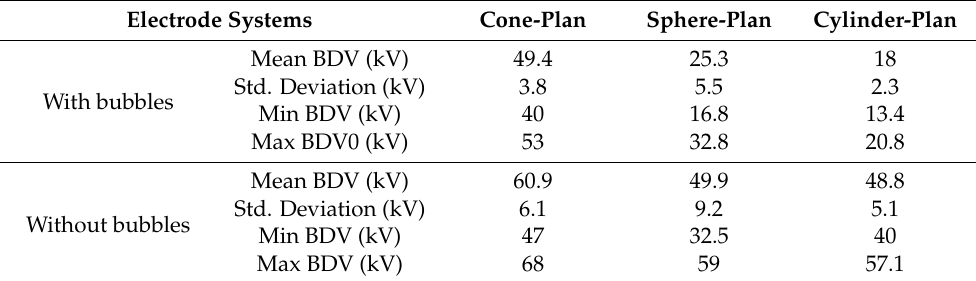
Table 2. Statistics of the AC breakdown voltages (BDV).